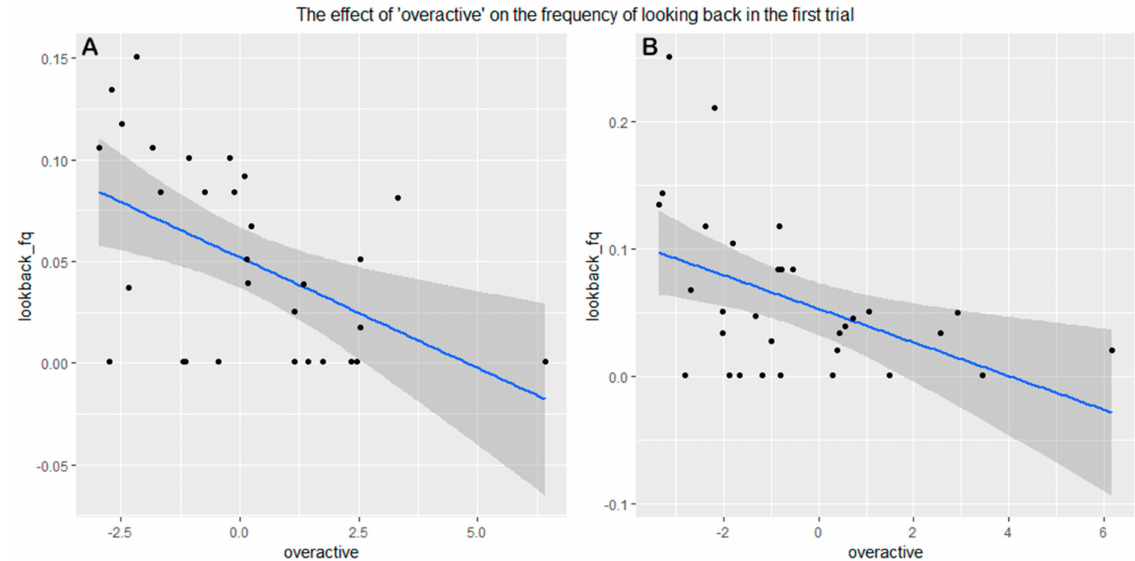
Figure 5. More “Overactive” dogs looked back less frequently at the owner in the first trial in both the ( A ) experimenter demonstration group and ( B ) owner demonstration group.